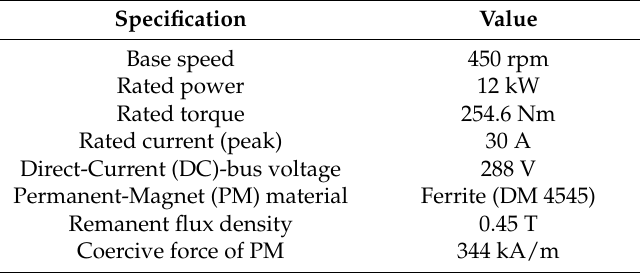
Table 4. Machine design